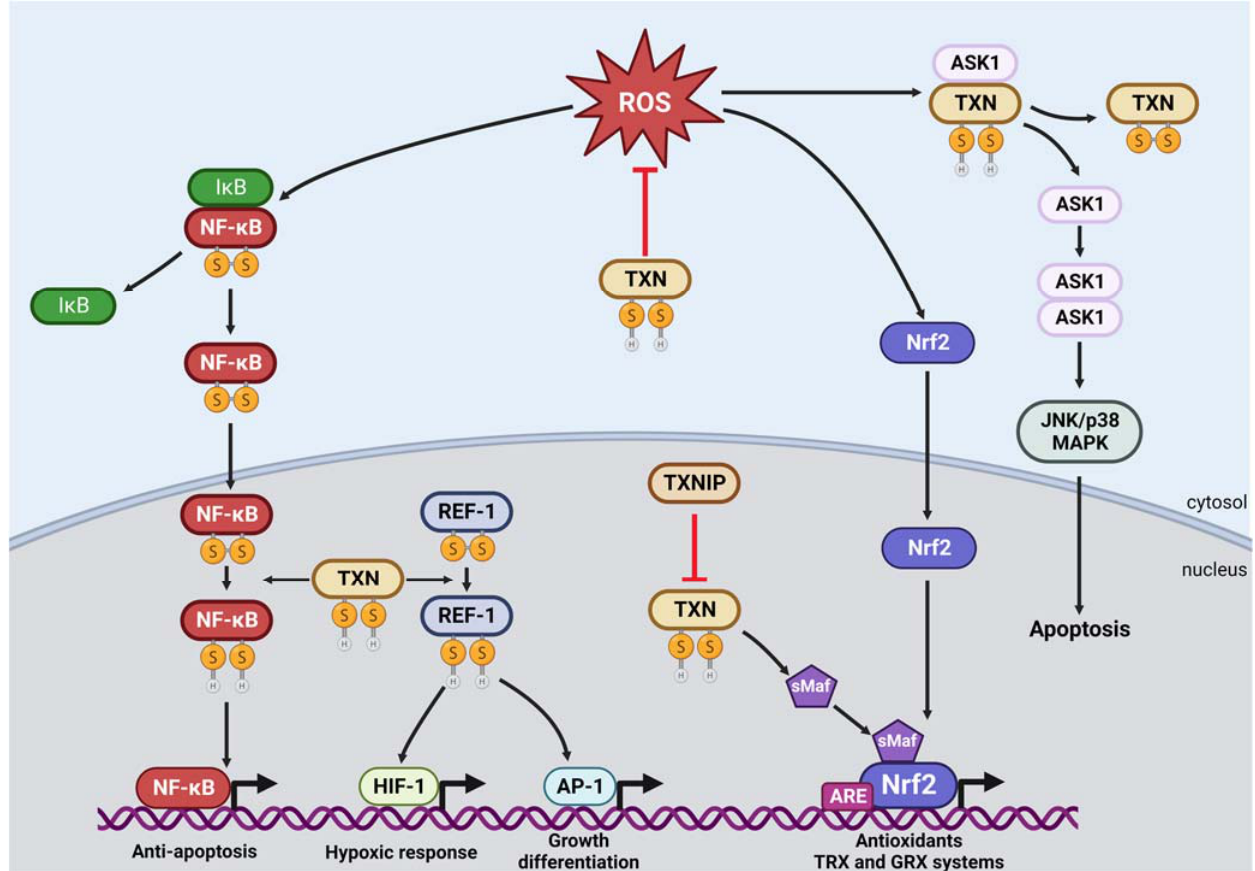
Figure 4. Role of thioredoxin in redox signaling. Thioredoxin (TXN) negatively regulates apoptosis via redox regulation of ASK-1 and inhibition of I κβ degradation by scavenging ROS in the cytoplasm. In the nucleus, TXN increases the DNA-binding activity of NF- κβ and can enhance the binding of Nrf2 to the antioxidant response element (ARE) through small Maf proteins (sMaf) via reduction of their cysteine residues. TXN also increases the DNA-binding activity of other transcription factors, such as AP-1 and HIF-1, indirectly via the reduction of intermediate Ref-1 cysteine residues. Thioredoxin-interacting protein (TXNIP) can inhibit TXN function by forming a mixed disul fi de bond with its reduced form. Note that although thioredoxin reductase is not depicted in this fi gure, it is important for the reduction of thioredoxin into its reduced, active form. It is the reduced, active form of thioredoxin that contributes to redox signaling. Red lines indicate an inhibitory e ff ect. S-S = oxidized form. SH = reduced form.